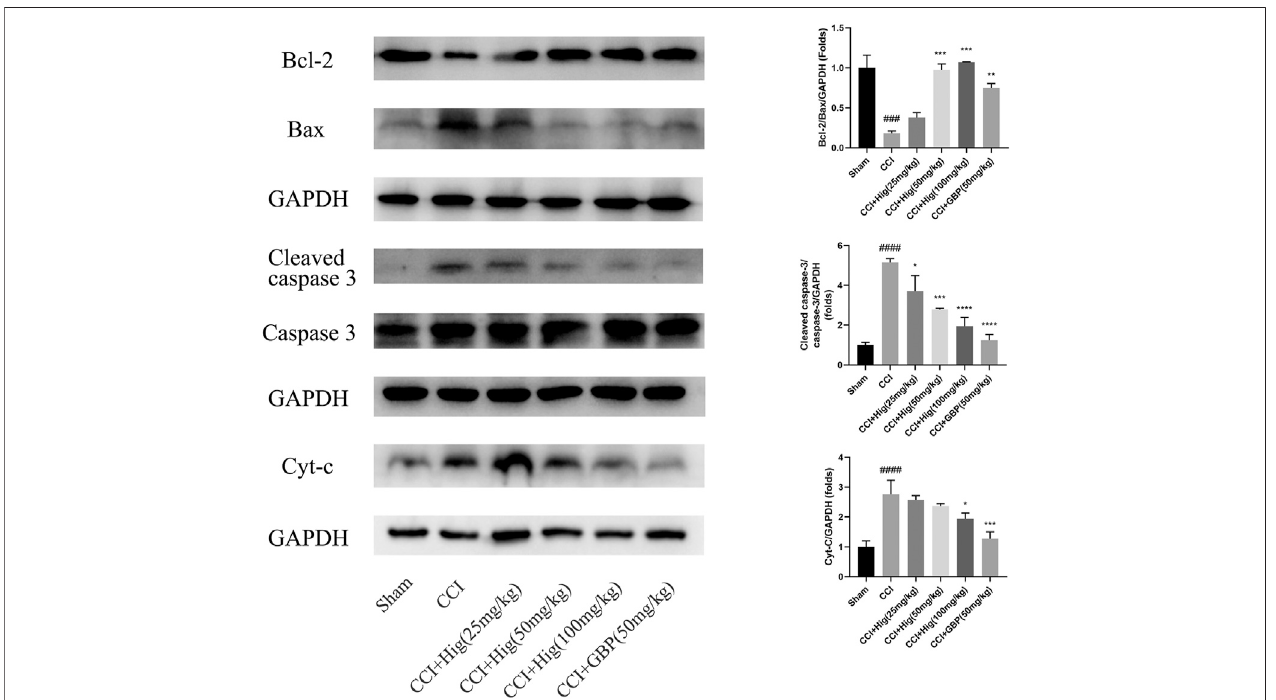
FIGURE8| HigprotectedDRGneuronagainstCCI-inducedoxidativestressandapoptosisbyregulatingmitochondrialpathway.WBanalysiswasusedtoquantify theratioofBcl-2/Baxandcleavedcaspase3/caspase3proteinlevelandtheexpressionlevelofcyt-cprotein.GAPDHwasconsideredasaninternalcontrol.Theresults are presented as mean ± SEM, n (cid:2) 3. ### p < 0.001 and #### p < 0.0001 vs. the control group. * p < 0.05, ** p < 0.01, *** p < 0.001, and **** p < 0.0001 vs. the t-BHP